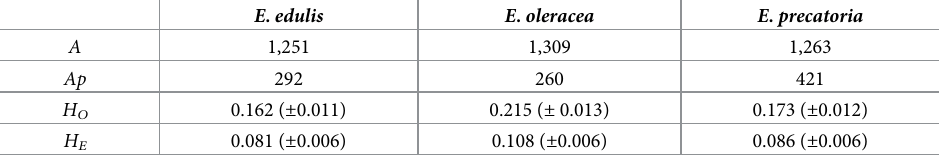
Fig 7. Majority-rule consensus tree of 30,000 trees obtained from a Bayesian inference analysis of chloroplast protein coding genes of 55 taxa. Posterior probabilities (PP) for each are indicated above branches. Co = Coryphoideae, Ar = Arecoideae, Ny = Nypoideae, Ce = Ceroxyloideae, Ca = Calamoideae. https://doi.org/10.1371/journal.pone.0266304.g007 Table 3. Parameters of genetic diversity using 1,077 SNPs found the nuclear and mitochondrial genome sequences from three Euterpe